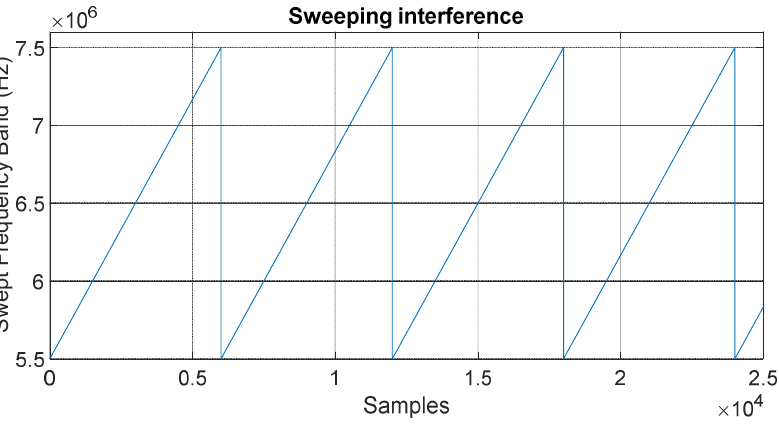
Figure 5. Example of a frequency ramp for the type of sweeping frequency jammer .